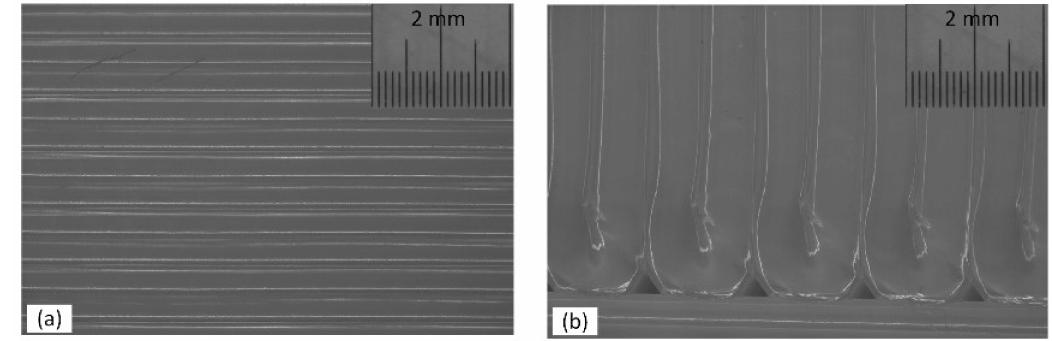
Figure 12. Light microscope image of: ( a ) dense structure obtained for samples built with 0 ◦ raster angle and ( b ) samples built with 90 ◦ raster angle showing incomplete fill and void at the edges.